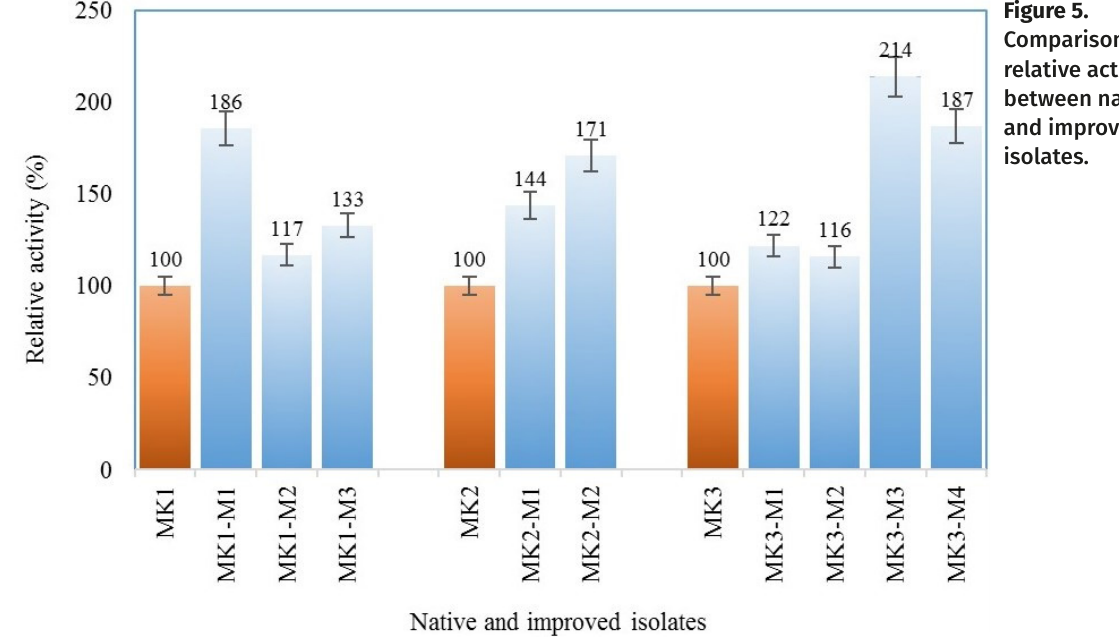
Figure 5. Comparison of relative activity between native and improved